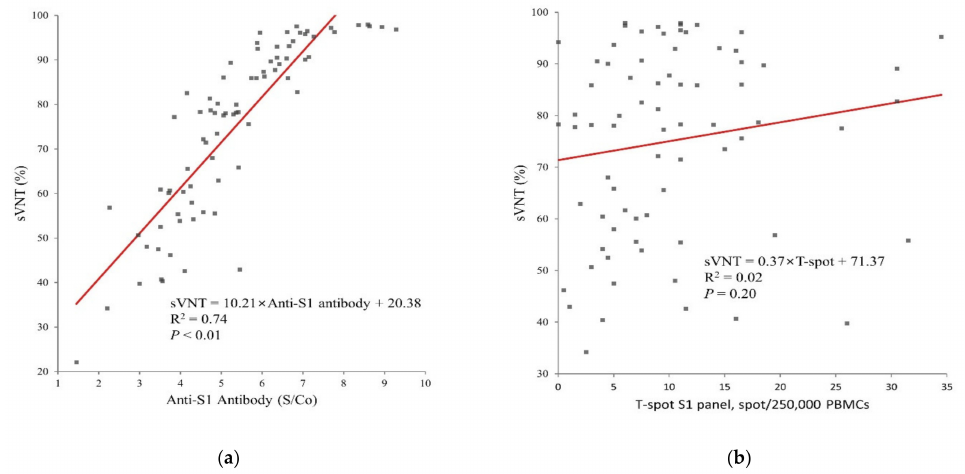
Figure 1. Relationship between the immunogenicity assays in 79 participants who are full vaccinated with AZD1222 ( a ) value of S/Co of anti-S1 antibody and sVNT (%) ( b ) Spots of Discovery SARS-CoV-2 kit S1 panel and sVNT. S/Co; signal to cut-off, sVNT; surrogate virus neutralization